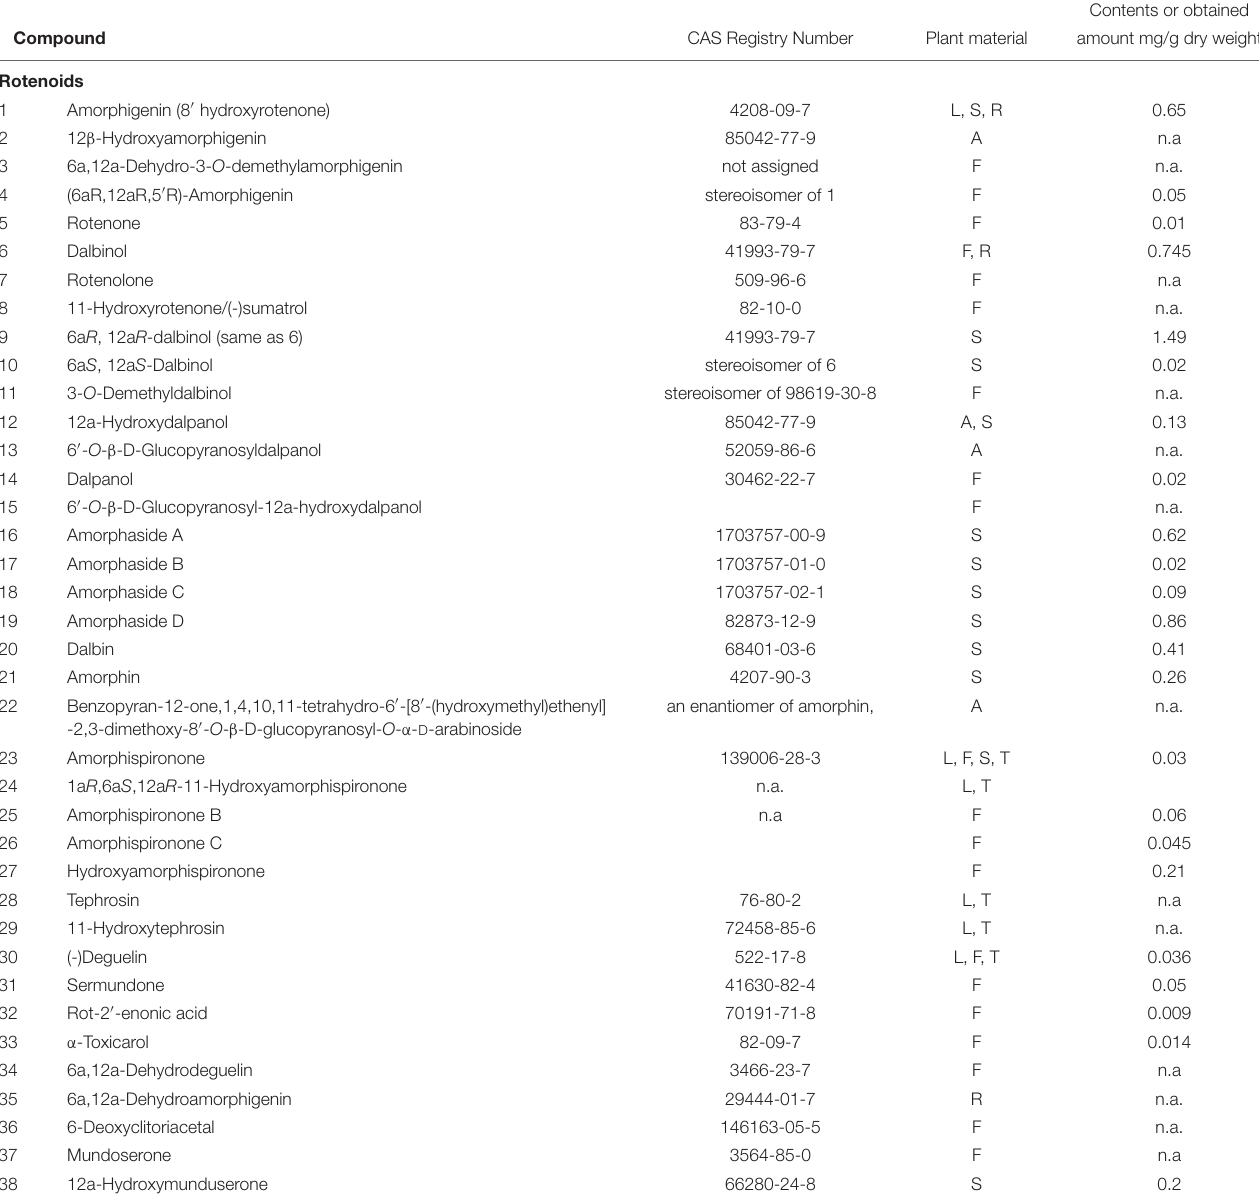
TABLE 1 | List of rotenoids isolated from various parts of Amorpha fruticosa